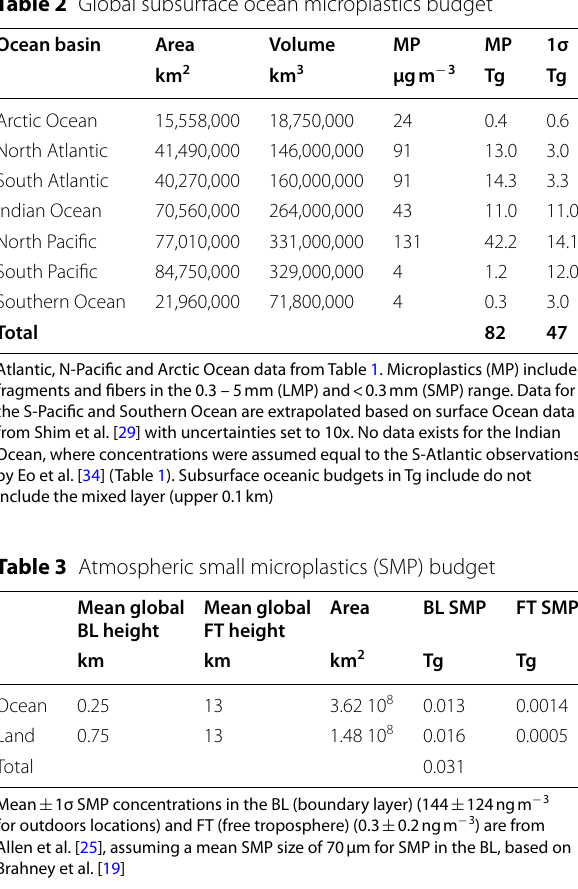
to remote terrestrial surfaces (soil, rock, deserts, ice). Table 2 Global subsurface ocean microplastics budget